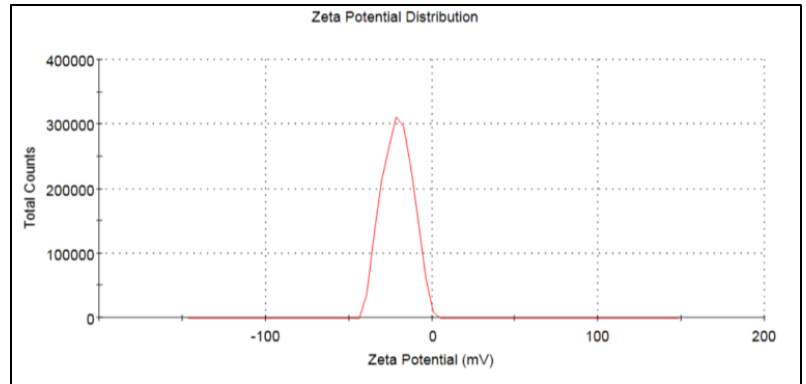
Figure 4. The zeta potential graph for biosynthesized CDs shows a zeta potential at − 20.8 mV.